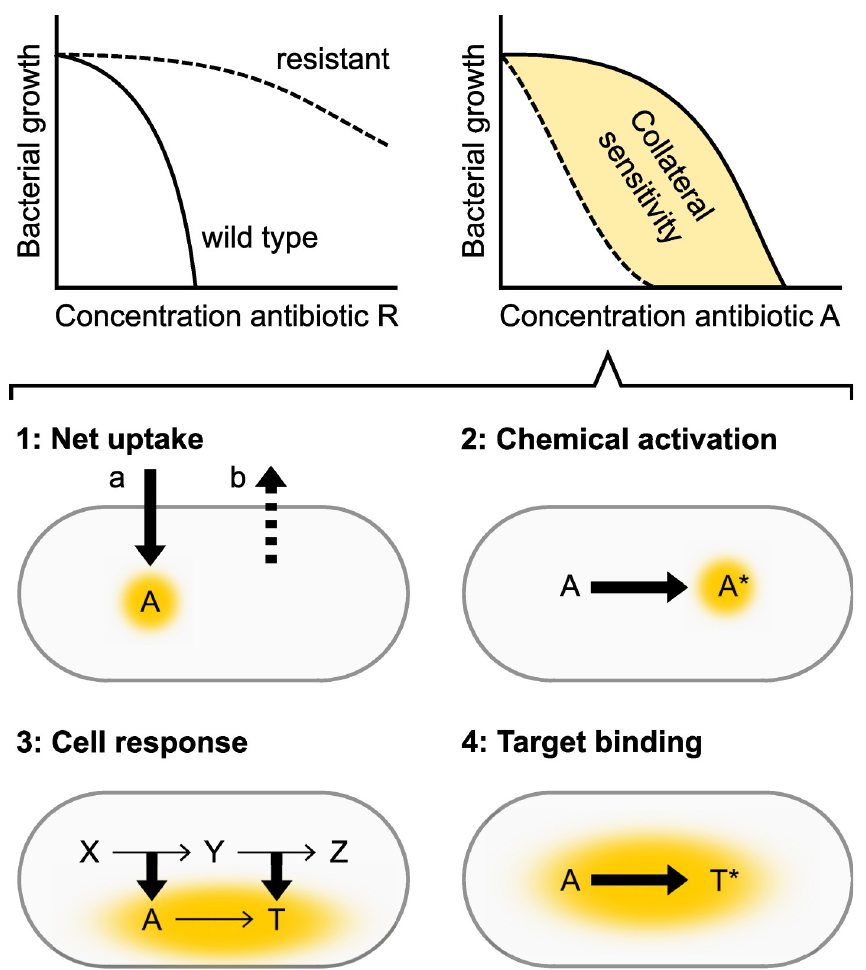
Fig 1. Mechanisms of collateral sensitivity. Schematic illustration of resistance (top left) and collateral sensitivity (top right) of a strain with resistance mechanism against antibiotic R . The resistant strain is indicated with a dashed line, and the susceptible wild-type strain with a solid line. Yellow shading indicates increased inhibitory activity of antibiotic A . The inhibitory effect of A that is generated upon binding of target structure T may be increased by several theoretical mechanisms (numbered 1–4). Bold arrows indicate increased functions. Broken arrows indicate reduced